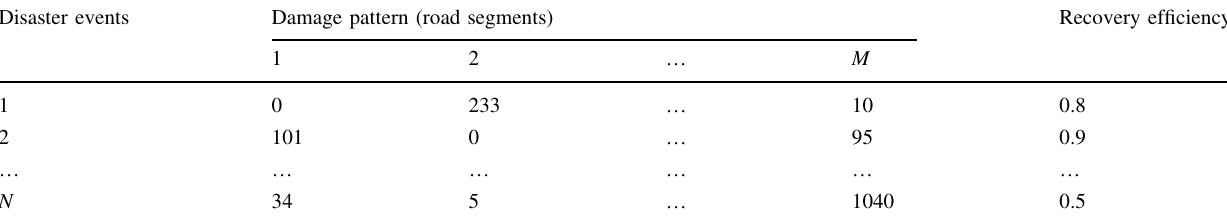
Table 4 Disaster events dataset including damage patterns, robustness, and recovery efficiency Disaster